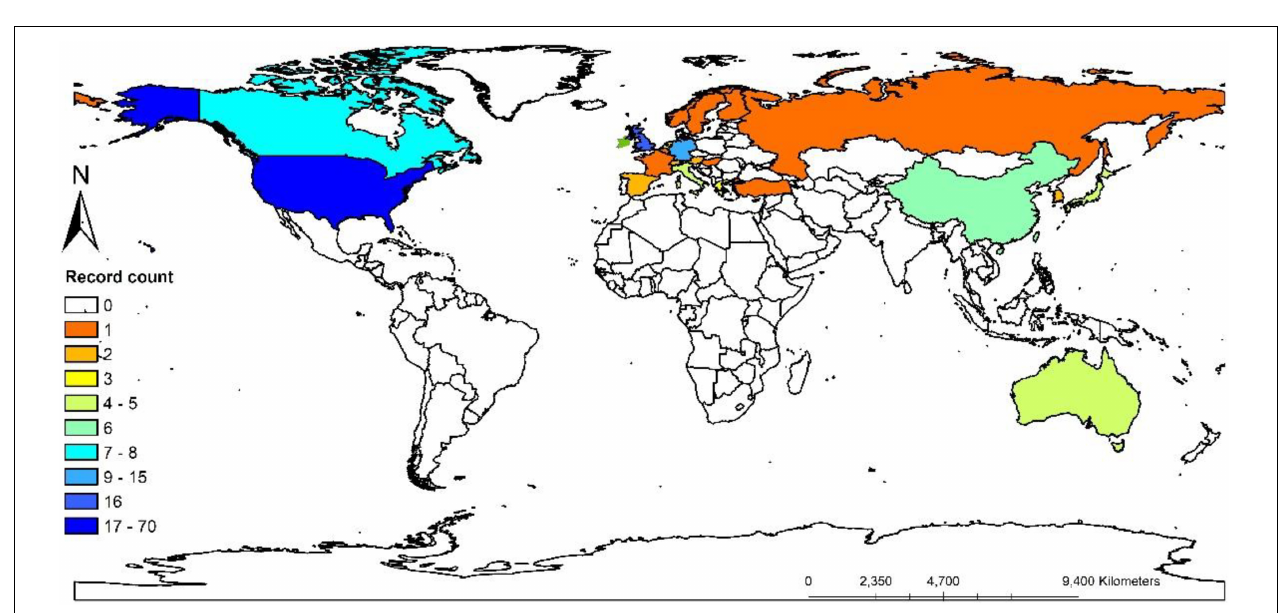
FIGURE 4 | Bibliographic coupling analysis highly cited countries, weighted by citations, visualized map.